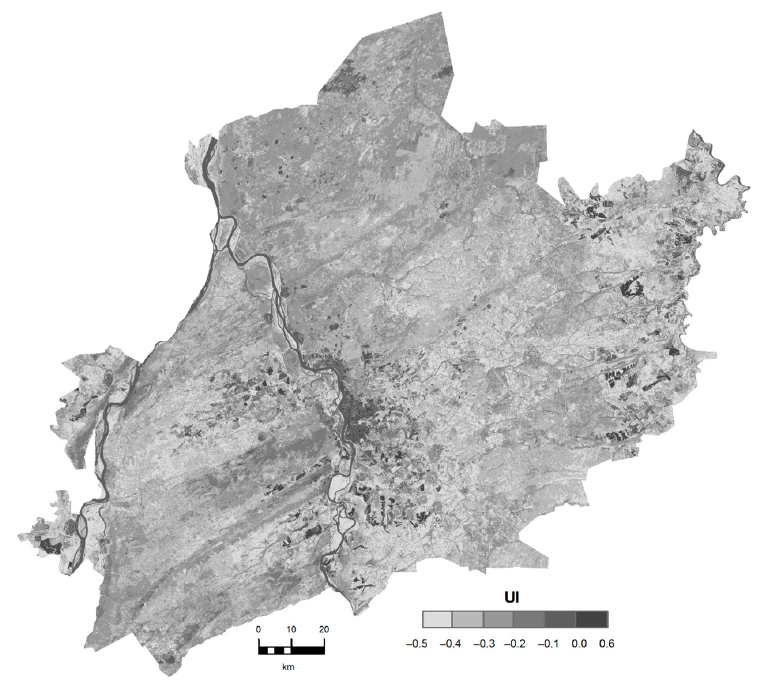
Figure 4. UI map. Figure 4. UI map.